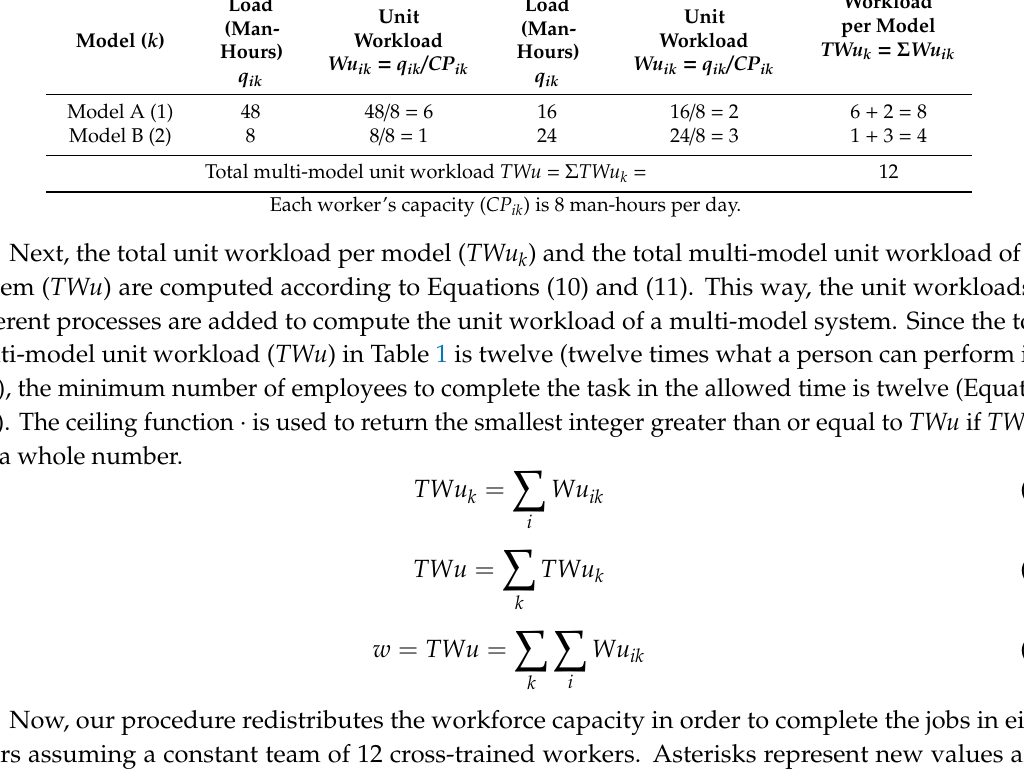
Table 1. Unit workload per operation ( Wu ik ) and per model ( TWu k ) and total load ( TWu ). Operation